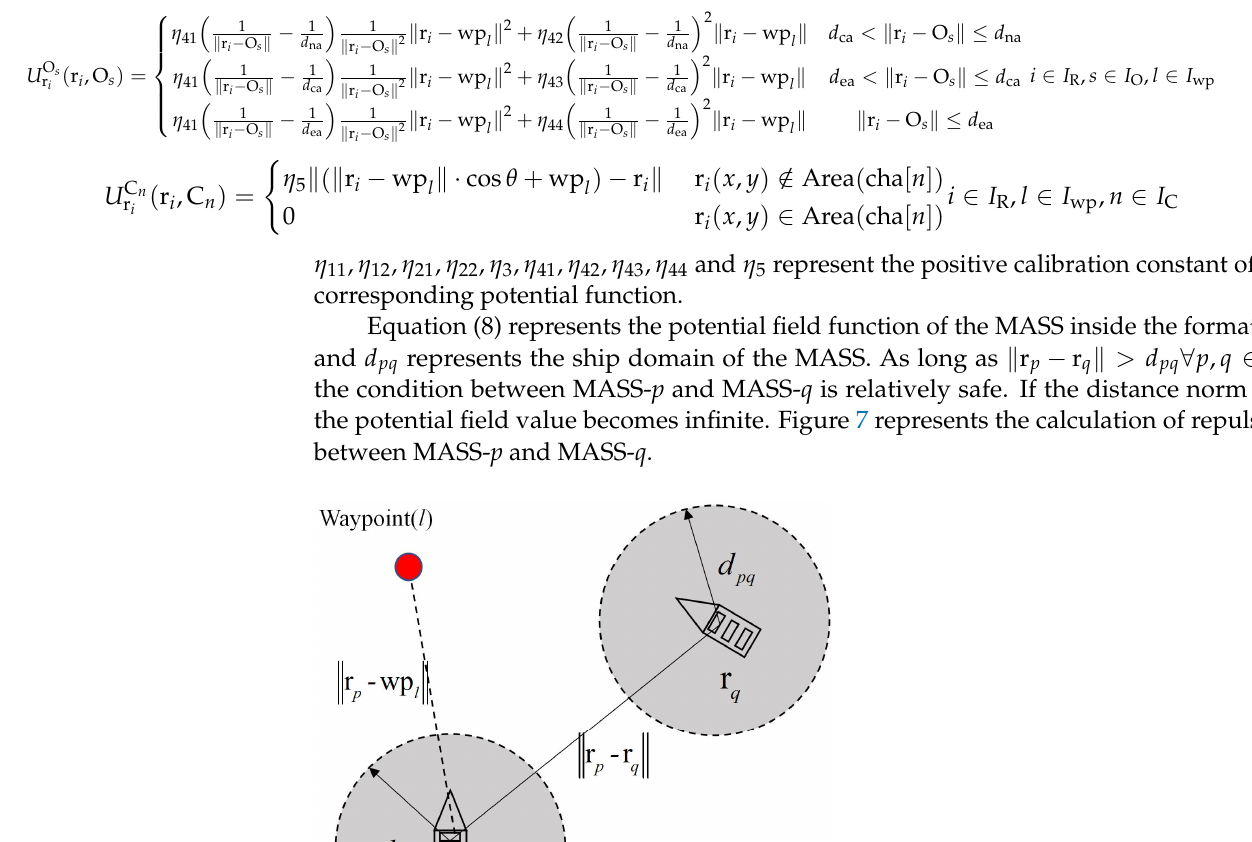
Figure 7. Calculation of the repulsion force between MASS- p and MASS- q.